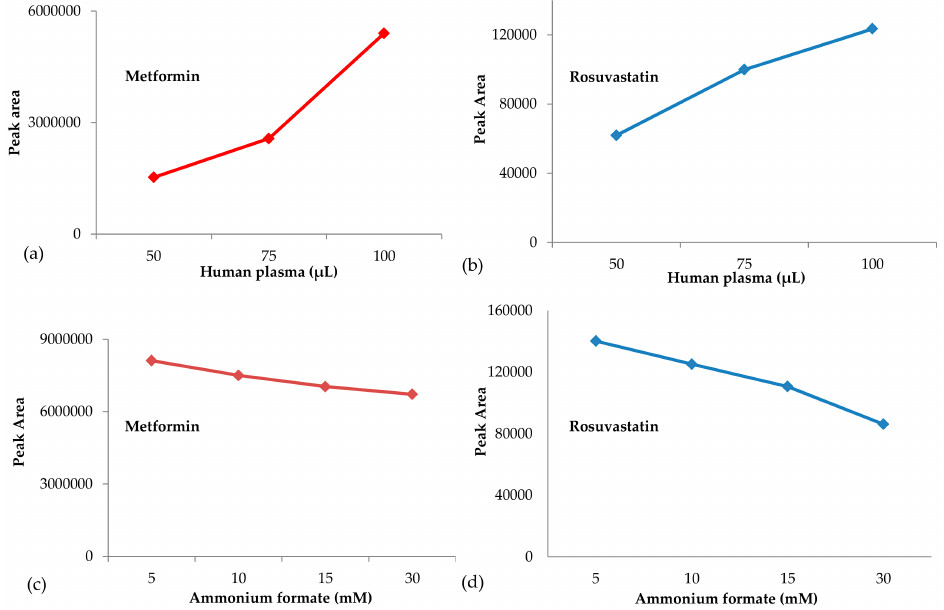
Figure 5. Effect of the proportion of the biological sample ( a and b ) and the concentration of a 30% ( v / v ) ammonium formate water solution in acetonitrile ( c and d ) on the peak area signal of metformin and ( b , d ) rosuvastatin.